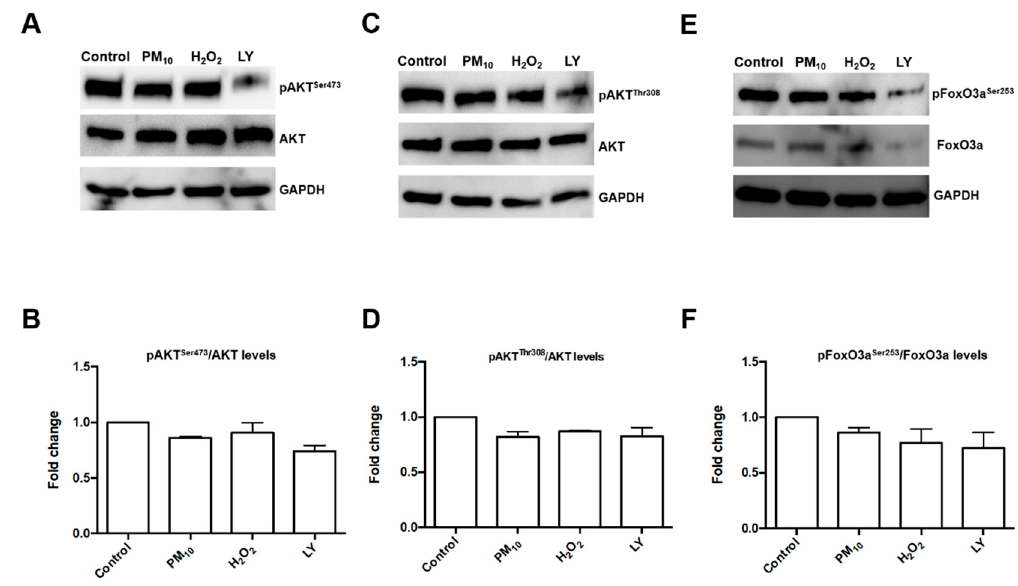
Figure 2. Levels of pAKT Ser473 , pAKT Thr308 , and pFoxO3a Ser253 proteins. Representative blot of ( A ) levels of pAKT Ser473 assessed; ( B ) densitometry of pAKT Thr308 protein levels using ImageJ software; ( C ) assessed pAKT Th308 levels; ( D ) densitometry of pAKT Ser473 protein levels using ImageJ software; ( E ) assessed pFoxO3a Ser253 levels; and ( F ) densitometry of pFoxO3a Ser253 protein levels using ImageJ software. Lung epithelial cells were exposed to PM 10 (10 µg/cm2) for 24 h, treated with H 2 O 2 (500 µM) for 24 h, and treated with LY294002 inhibitor (LY) (50 µM) for 1 h before the H 2 O 2 (500 µM) treatment. Glyceraldehyde 3-phosphate dehydrogenase (GAPDH) protein was used as loading control for western blot. The image is representative of three independent experiments, and values are the mean ± SD of three independent experiments.